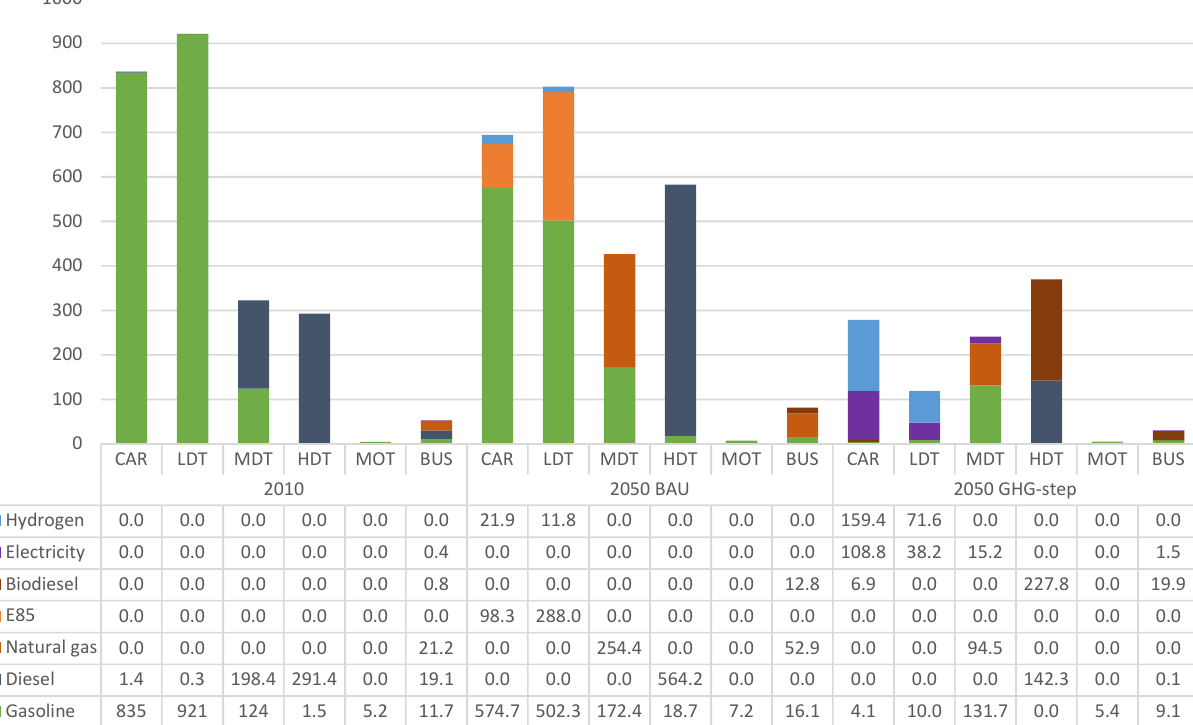
Figure 4. CA-TIMES energy consumption by vehicle weight class, fuel, and scenario for on-road sources. Vehicle categories include car,